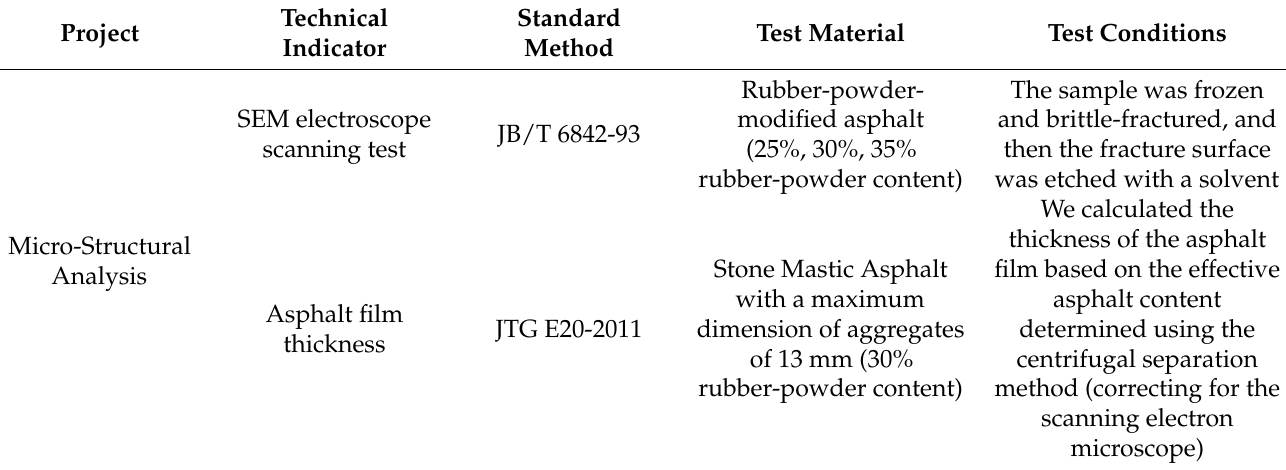
Table 2. Micro-scale characteristic test